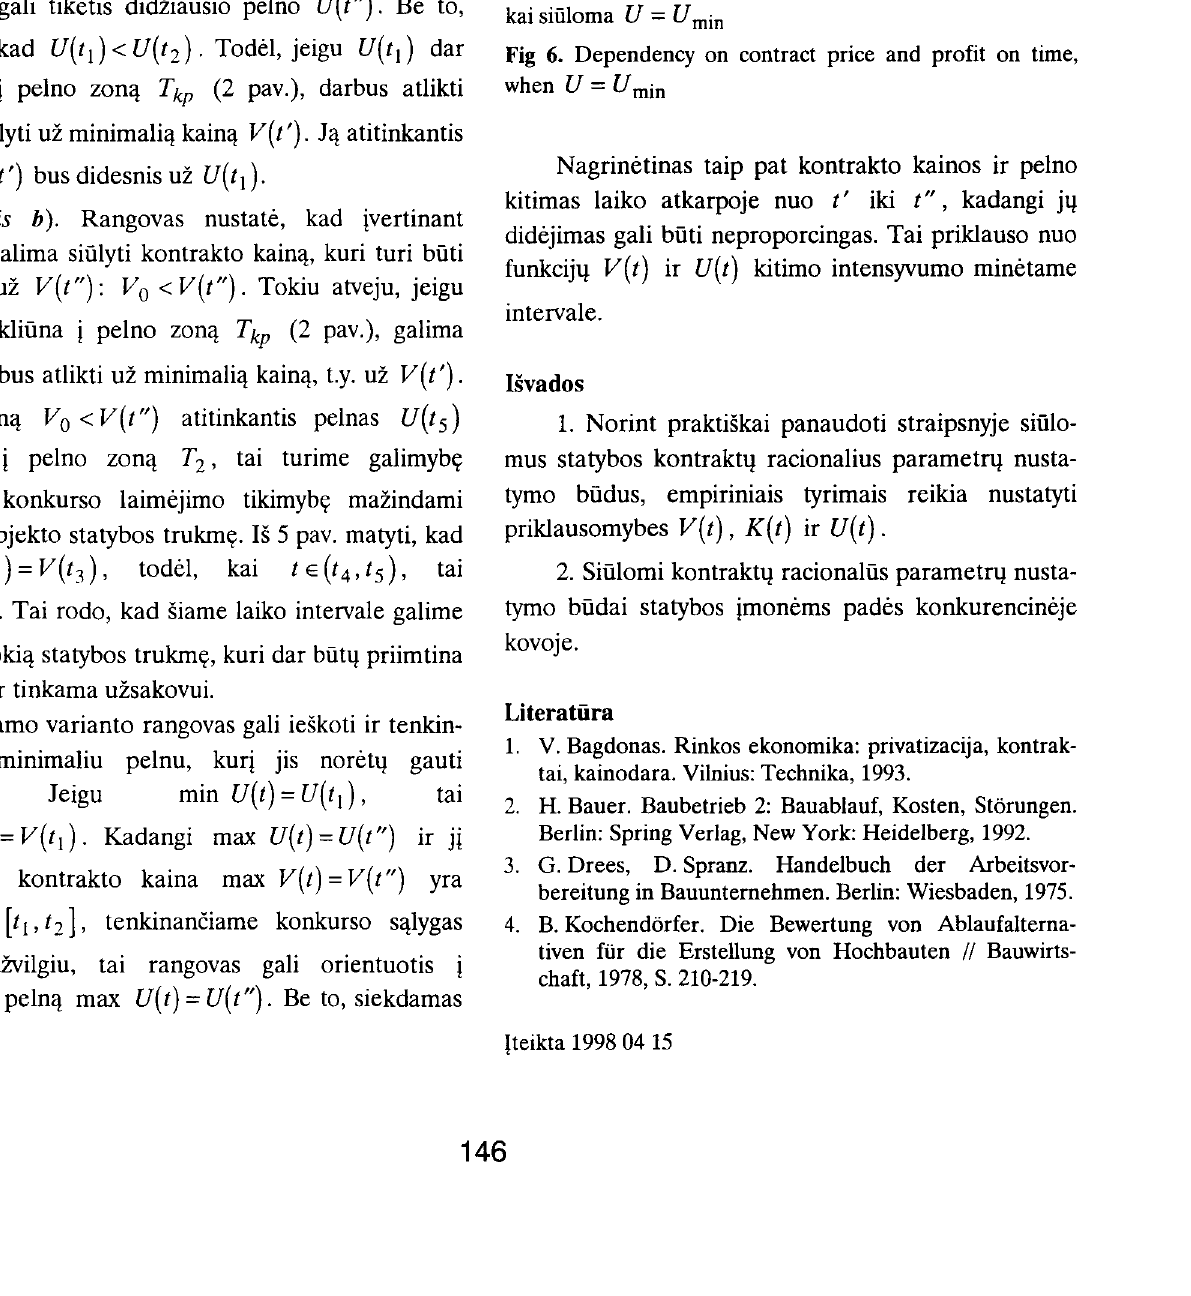
Fig 6. Dependency on contract price and profit on time, when U = Umin Nagrinetinas taip pat kontrakto kainos ir pelno kitimas laiko atkarpoje nuo t' iki t" , kadangi jq didejimas gali buti neproporcingas. Tai priklauso nuo funkcijq V(t) ir U(t) kitimo intensyvumo